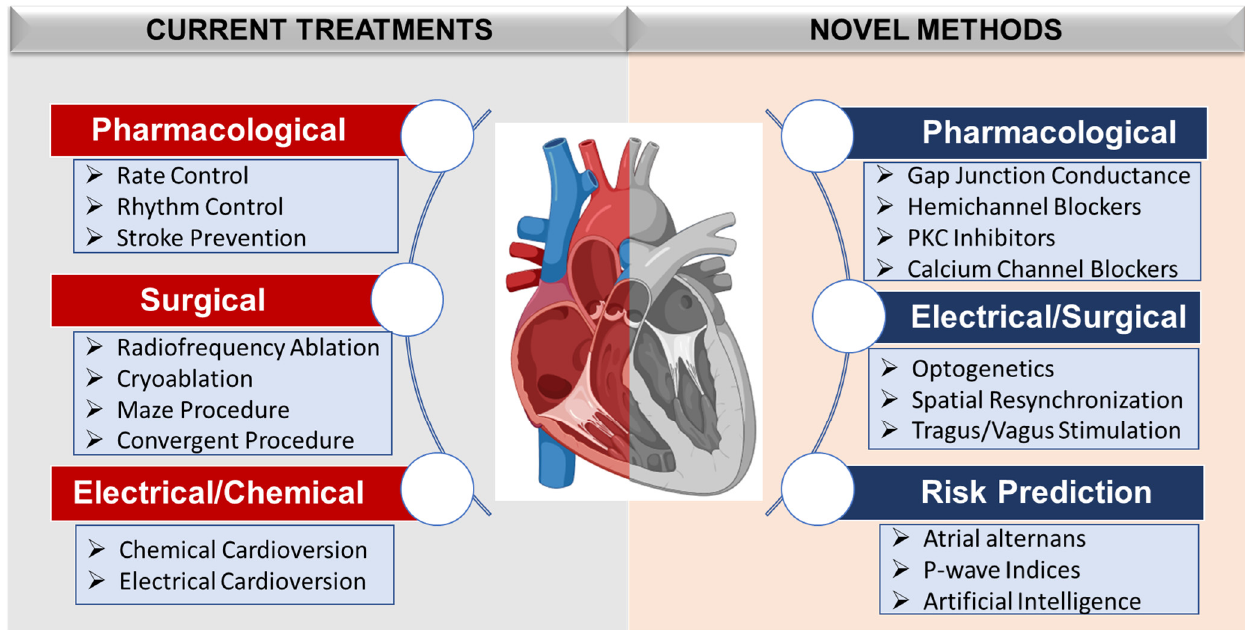
Figure 1. Atrial fibrillation: current and upcoming treatment